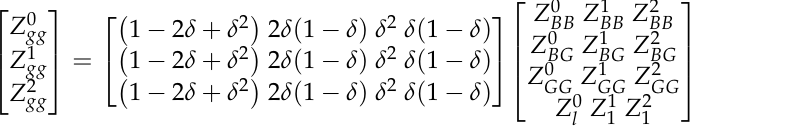
Figure 3. Short-circuit faults in line B-C and perceptive P-Q bus